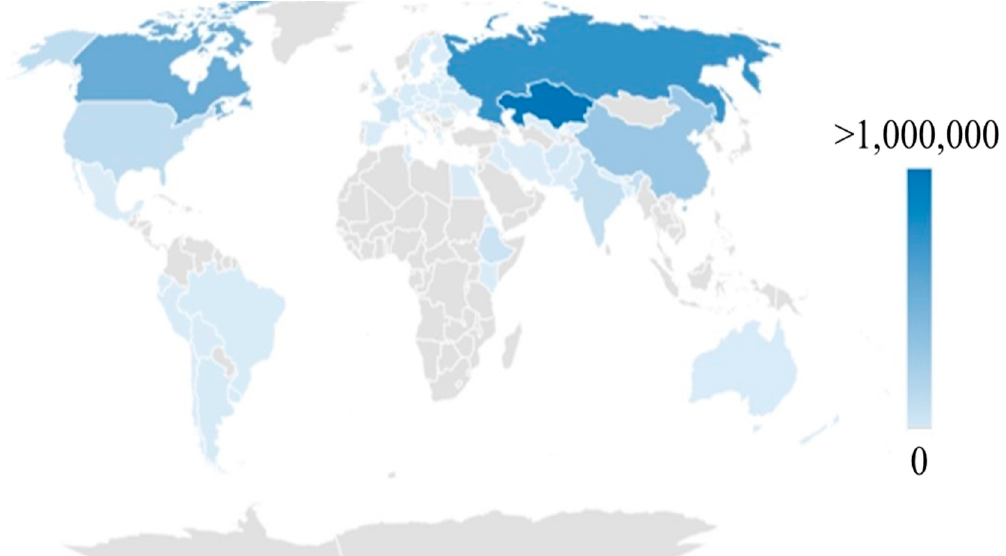
Figure 1. Global production of flaxseed in 2020. In the color scale of the figure the light gray areas correspond to 0 tons whilst dark blue ones correspond to over 1,000,000 tons of produced linseed. Data retrieved from https://www.fao.org/faostat/en/#data/QCL (accessed on 10 January 2023) [1].